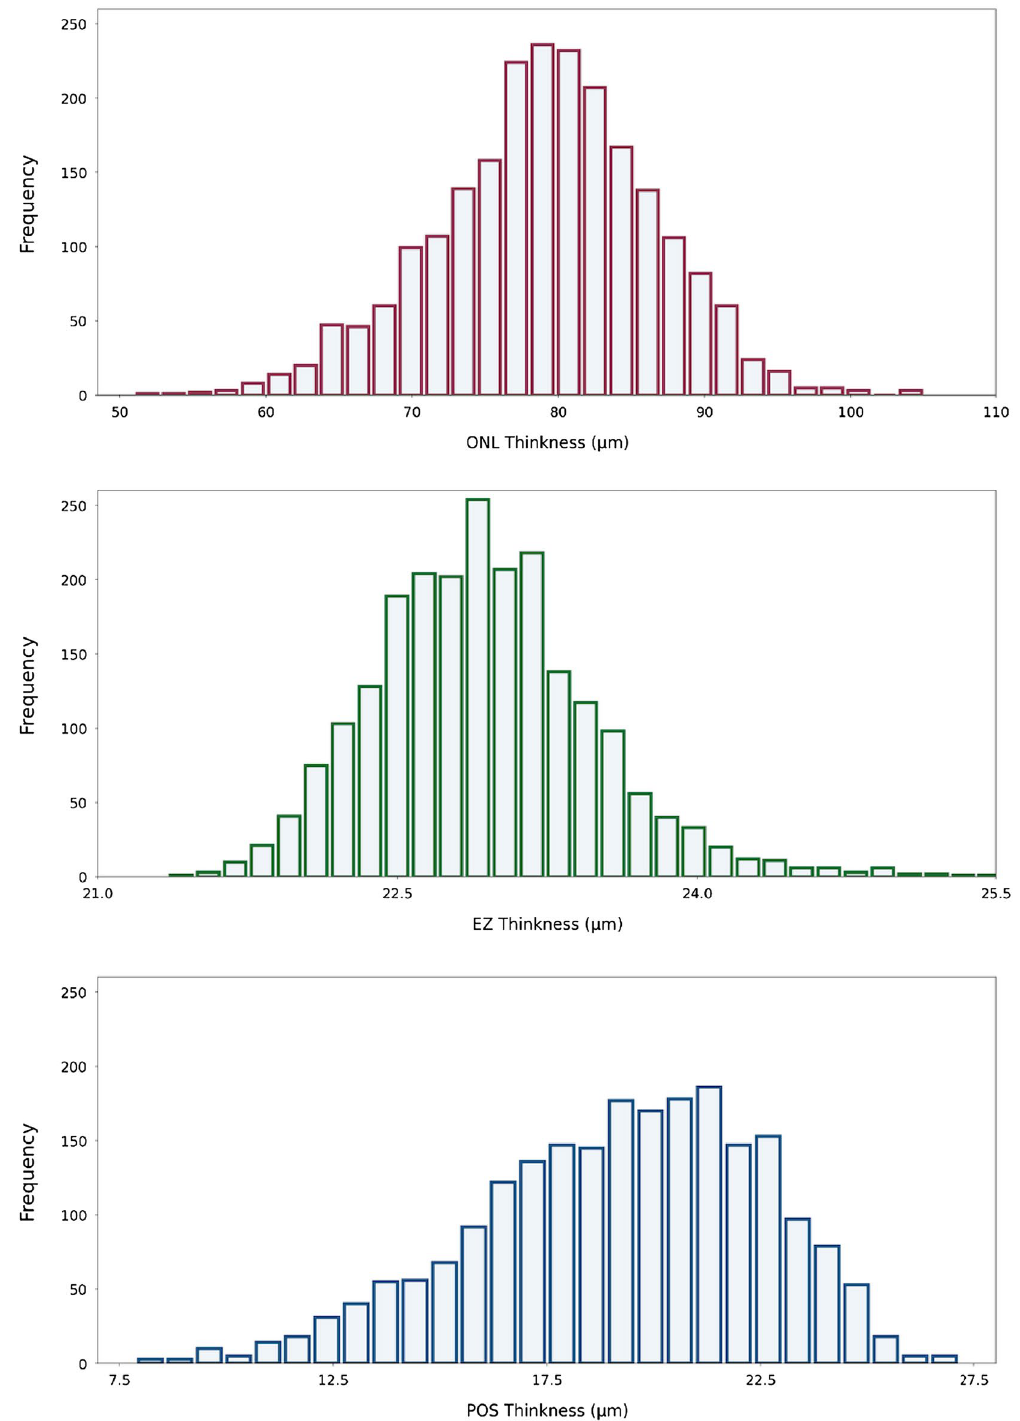
Figure 2. Graph showing the distribution of the thickness of the retinal outer nuclear layer (ONL), the ellipsoid zone (EZ), and the photoreceptor outer segment band (POS) in the Beijing Eye